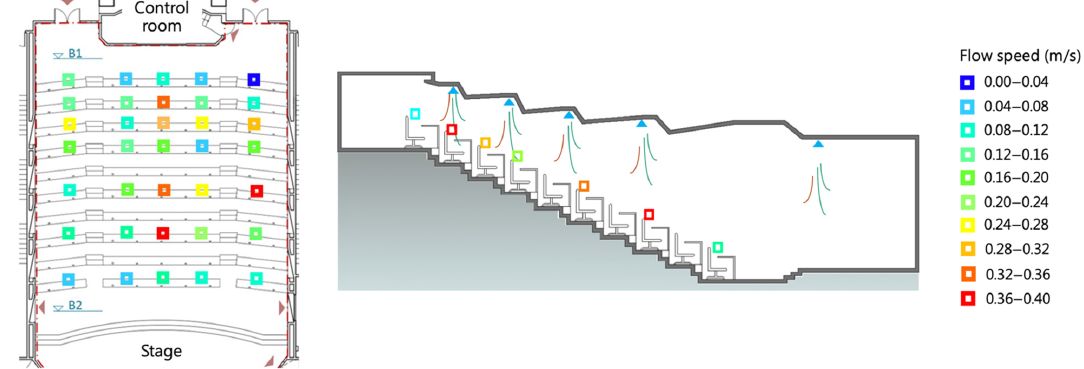
Buildings 2022 , 12 , x FOR PEER REVIEW Figure 11. Air velocity distribution measurement results: plan and profile of the case room.